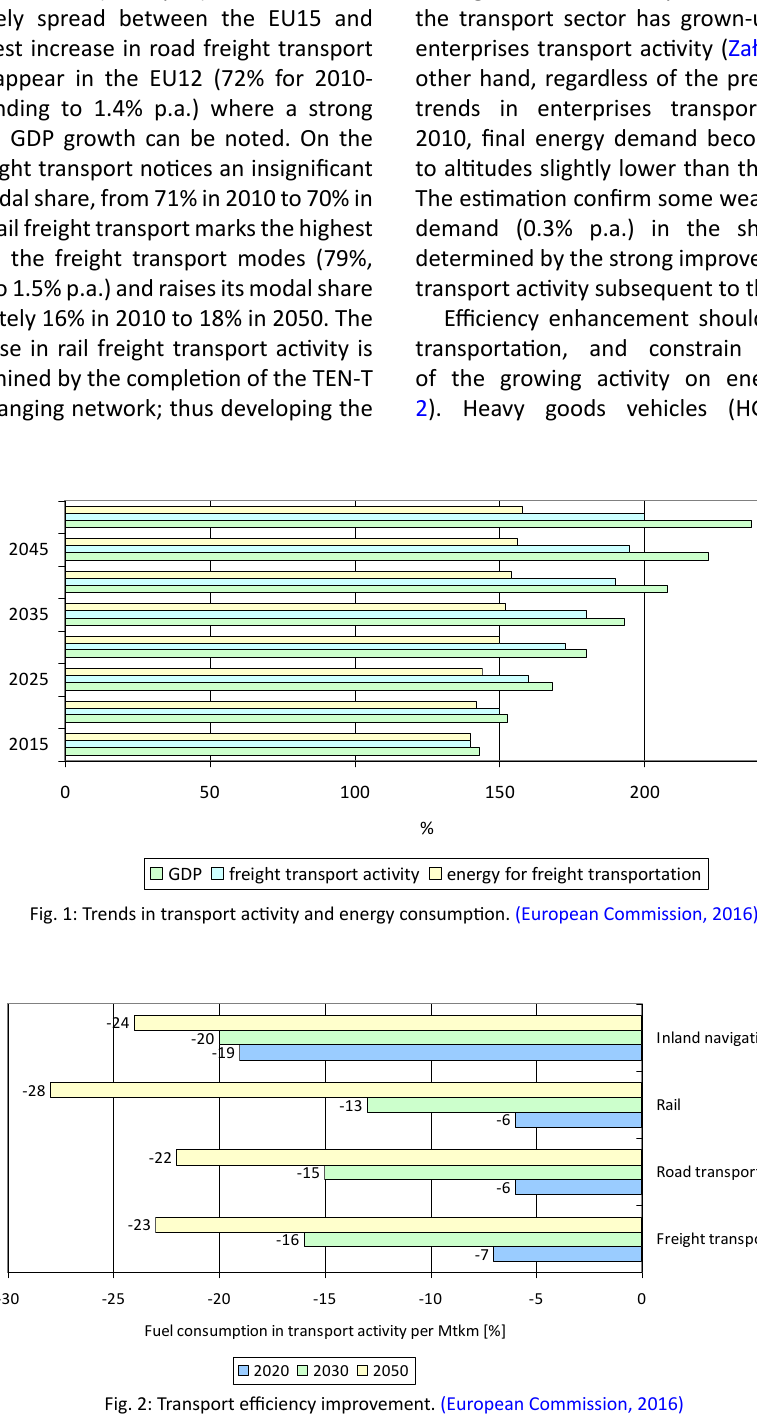
Fig. 2: Transport efficiency improvement. (European Commission, 2016)